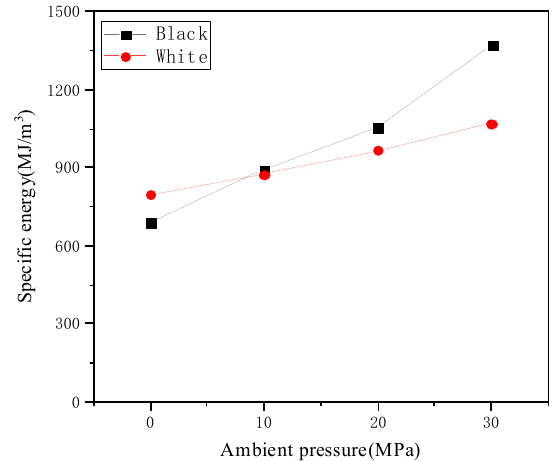
Figure 19. Relationships between ambient pressure and SE.